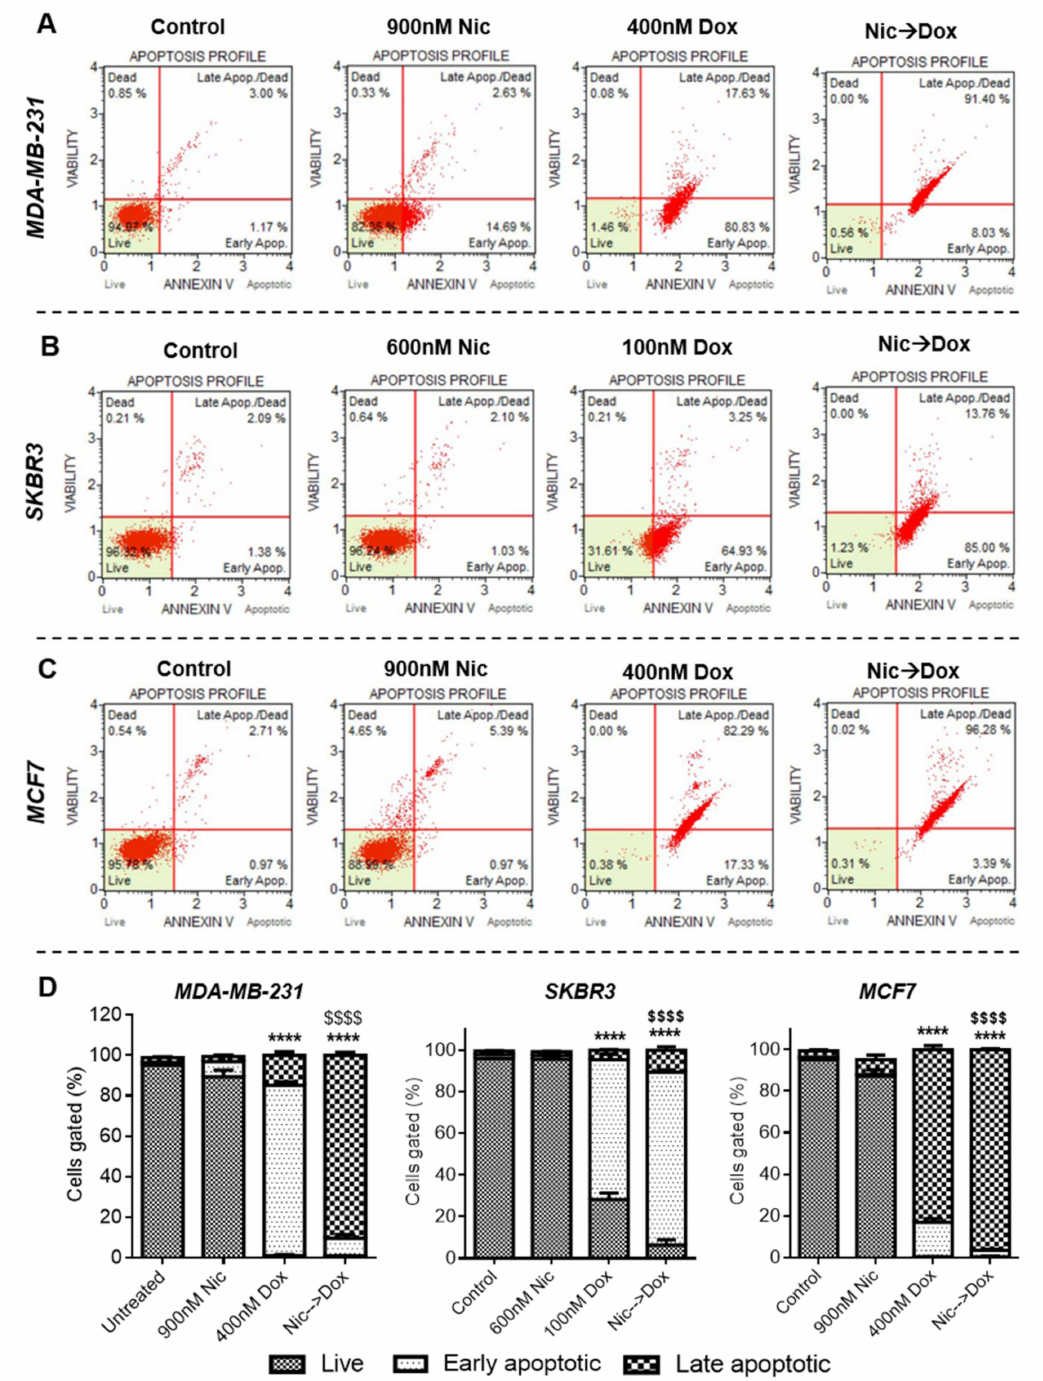
Figure 2. Apoptosis analysis of breast cancer cells after individual and sequential treatment of Nic and Dox at indicated doses for 24 h. Flow cytometer scatter plots of ( A ) MDA-MB-231, ( B ) SKBR3, and ( C ) MCF7 cells showing apoptosis profiles of different treatment groups. ( D ) Quantitative representation of apoptosis profiles shown in ( A – C ). **** indicates statistically significant increase ( p < 0.0001) in percentage of total apoptotic cells in Dox and sequentially treated group with respect to Nic and untreated groups; $$$$ indicates statistically significant increase ( p < 0.0001) in percentage of late apoptotic cells in sequentially treated group with respect to individual Dox group; ( n =